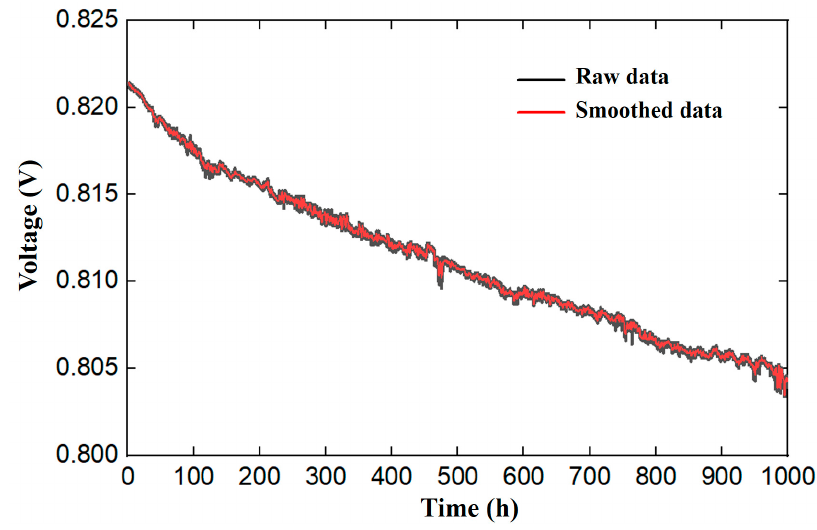
Figure 4. Raw and smooth long-term degradation data of the SOFC